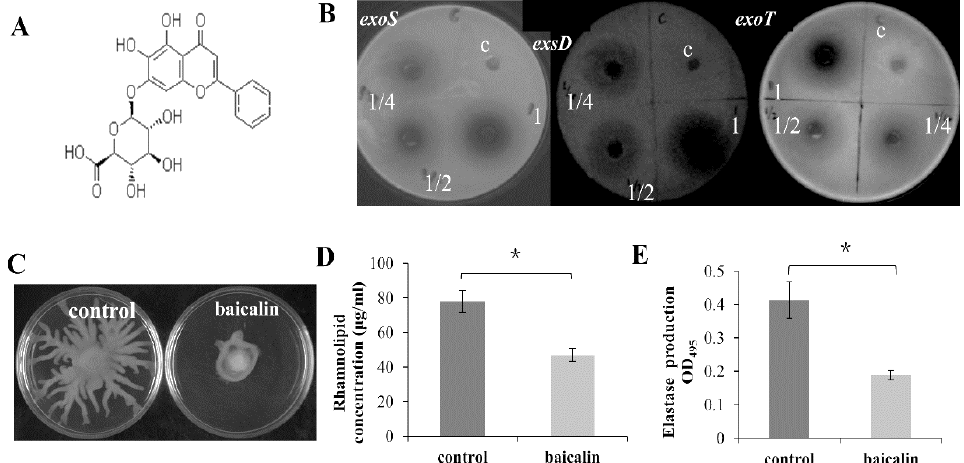
Figure 2. Repression on the virulence genes expression and phenotypes in P. aeruginosa by baicalin ( A ) The chemical structure of baicalin. ( B ) Inhibition on the expression of T3SS genes exoS , exsD , and exoT by baicalin. Five microliters of baicalin solution was dropped on the plates. 1, 1/2 and 1/4 represent that the concentrations of baicalin are 25, 12.5 and 6.25 mg/mL respectively; C, solvent as control. ( C ) Repression of swarming motility bybaicalin. Baicalin was added at 250 µ g/mL. Inhibition of rhamnolipid production ( D ) and elastase production ( E ) by baicalin. Baicalin was added at 250 µ g/mL. Averages of triplicate experiments ± standard errors of the means are shown. The results shown are representative of three independent experiments with similar trends. * significant difference ( p <